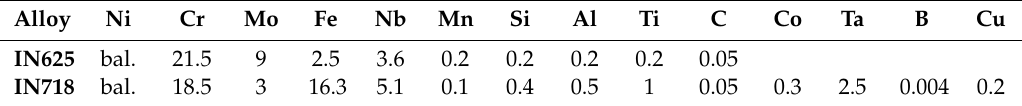
Table 1. Chemical composition of the materials in wt %. IN625: Inconel 625, IN718: Inconel 718.